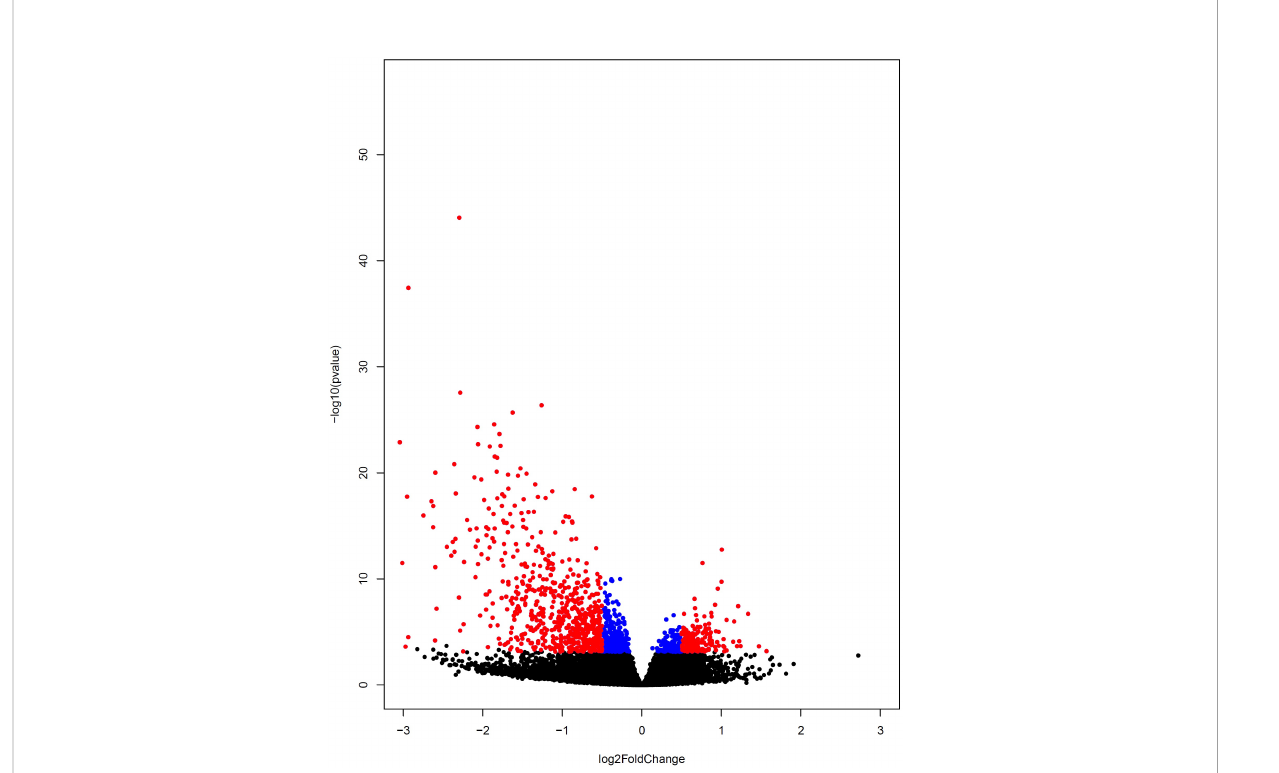
FIGURE 4 Volcano plot representing differential gene expression between COVID-19 and healthy subjects. The up-regulated and down-regulated DEGs are depicted by colors of red and blue, respectively. The non-DEGs are speci fi ed by the black